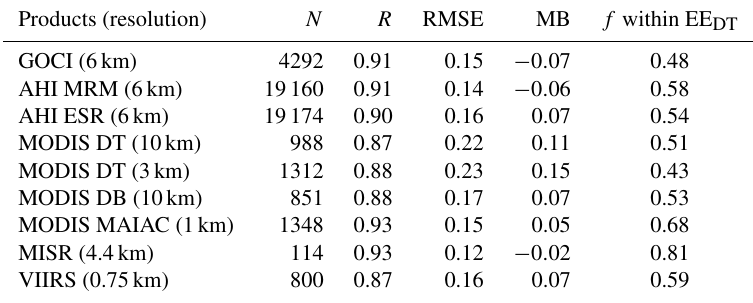
Table 3. Validation statistics for land AOD products using AERONET.